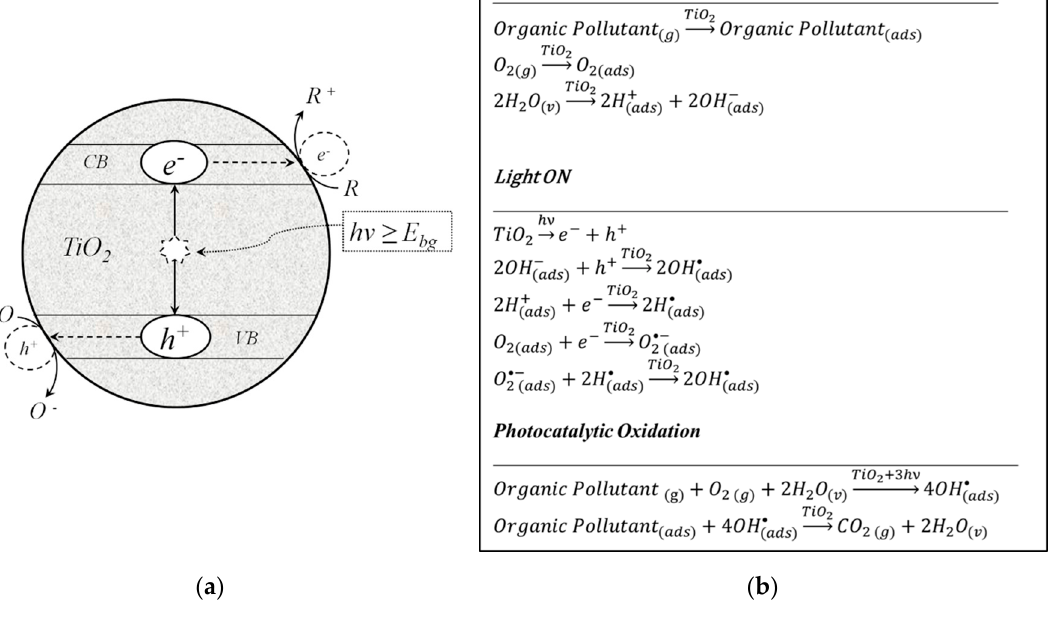
Figure 1. General photocatalytic reaction mechanisms: ( a ) illustration of TiO 2 and energy photons interacting with adsorbed pollutants and ( b ) photochemical reaction steps.